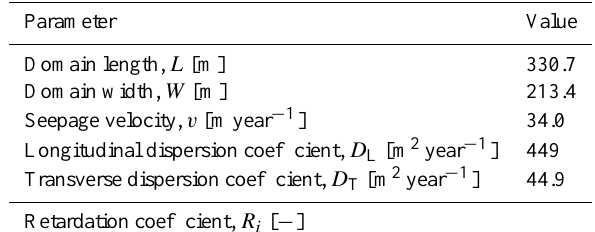
Table 11. Coefficients of Bateman-type boundary source used for example application involving the five-species dissolved chlori- nated solvent problem used by